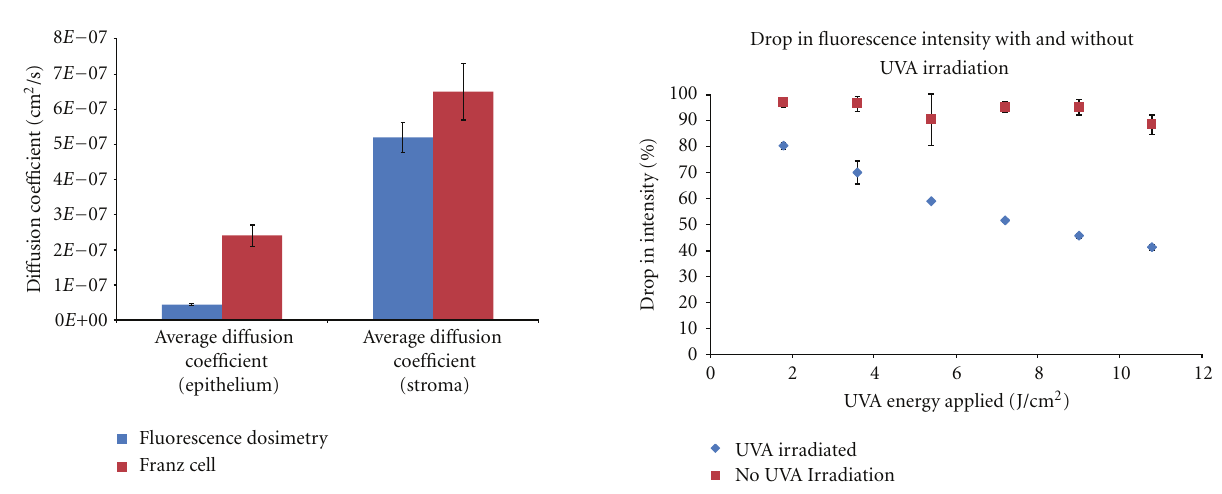
Figure 7: Drop in fluorescence intensity of the top 12 microns of the cornea with and without UVA